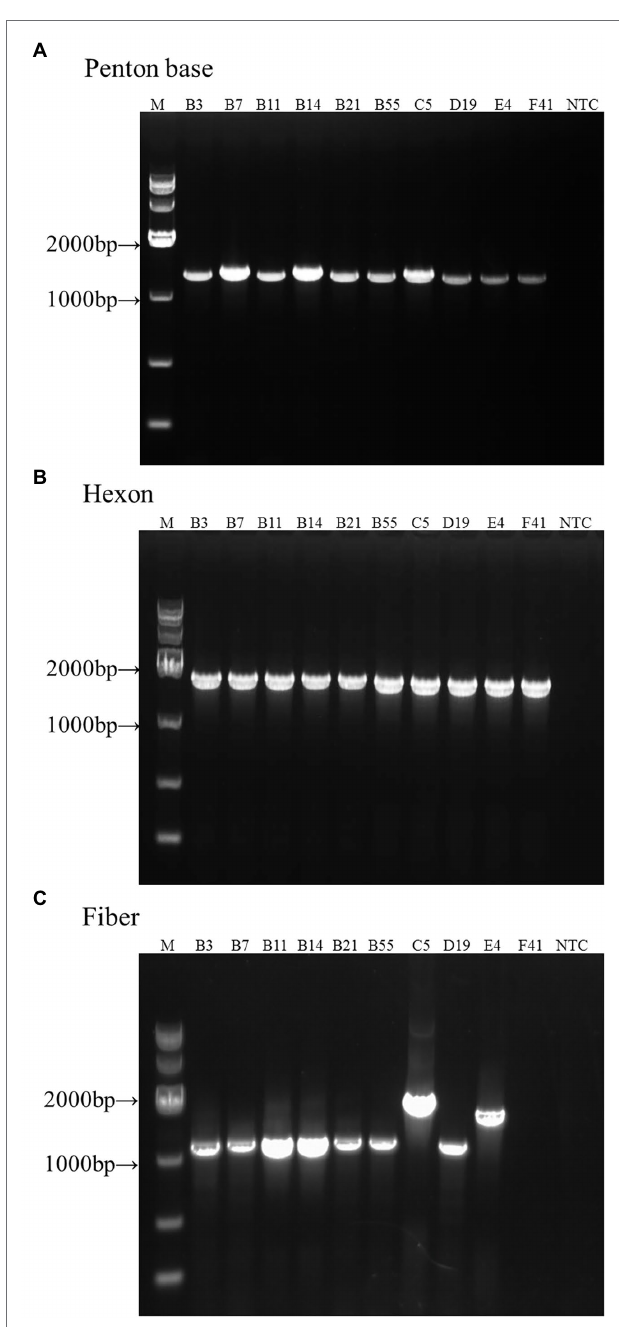
FIGURE 2 | One percent Agarose gel electrophoresis profiles of PCR products from HAdV-B3, -B7, -B11, -B14, -B21, -B55, -C5, -D19, -E4, and -F41 using universal primers for penton base, hexon, and fiber genes. (A) Penton base gene PCR amplification using primers Penton-F and Penton-R. (B) Hexon gene PCR amplification using primers HVR-F and HVR-R. (C) Fiber gene PCR amplification using primers Fiber-F and Fiber-R (Fiber-CR for HAdV-C5). Molecular weight sizing markers are in lane M. NTC, “no template” PCR